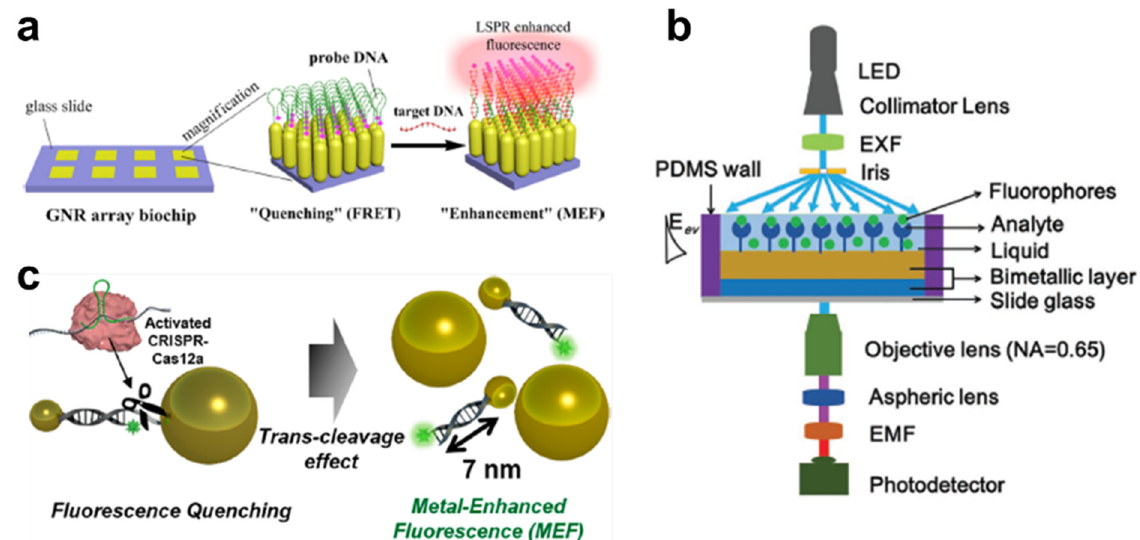
Figure 4. MEF-based nanobiosensor for DNA detection. ( a ) Schematic diagram of vertical Au-nanorod array for MEF-assisted DNA detection. This figure is reproduced from [86] (© 2017 American Chemical Society); ( b ) The straight (transmission) geometry-based bimetallic biosensing platform for the MEF-assisted DNA-detection system. This figure is reproduced from [87] (© 2018 John Wiley & Sons); ( c ) Schematic illustration of the CRISPR-Cas12a–based fluorescent biosensor for detection of DNA via a MEF using DNA-functionalized AuNPs without nucleic acid amplification. This figure is reproduced from [92] (© 2021 American Chemical Society).